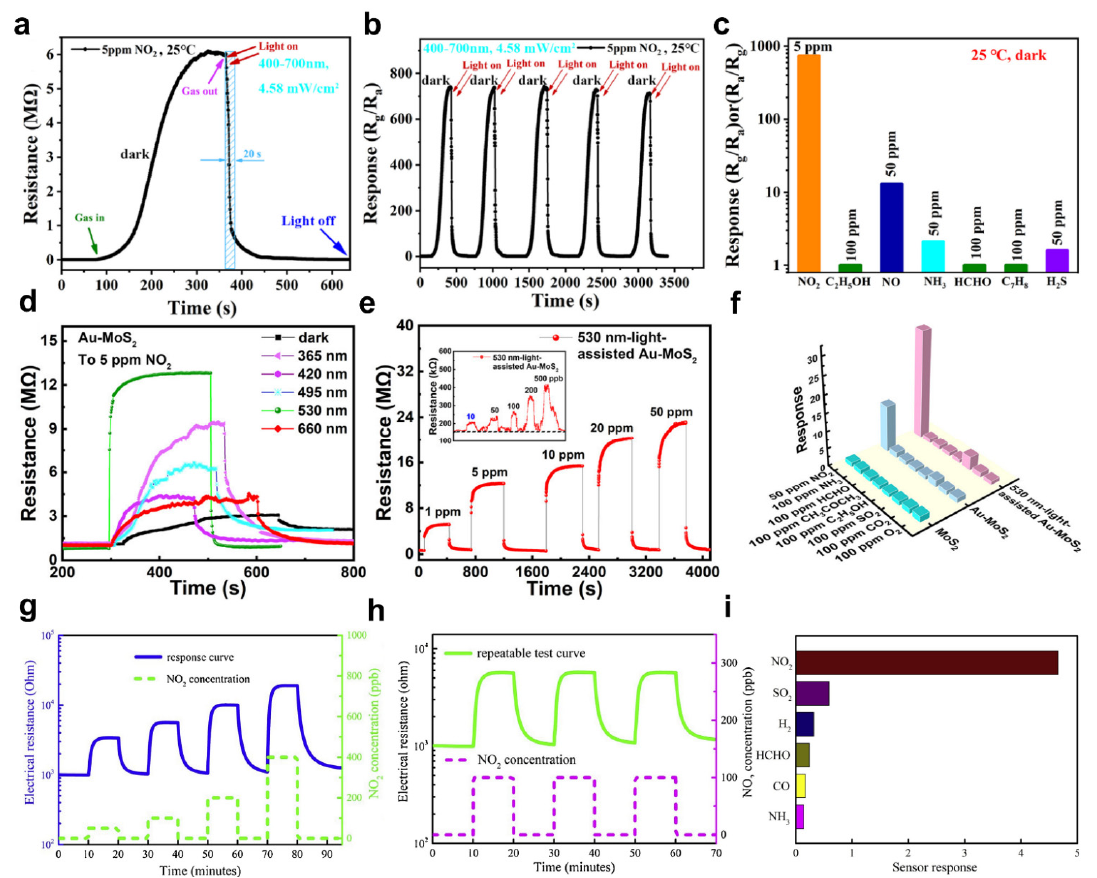
Figure 7. ( a ) Response of the In 2 O 3 NWs gas sensor with visible light irradiation; ( b ) stability characteristics of the In 2 O 3 NWs gas sensor; ( c ) selectivity characteristics of the In 2 O 3 NWs gas sensor (adapted from [99] with permission from the Elsevier B.V.); ( d ) response of the Au − MoS 2 gas sensor with UV and visible light; ( e ) response of the Au − MoS 2 gas sensor with various NO 2 gas concentration; ( f ) selectivity characteristics of the Au − MoS 2 gas sensor (adapted from [100] with permission from the American Chemical Society); ( g ) electrical resistance response of the rGO@ZnO sensor with white light illumination; ( h ) repeated NO 2 gas response of the rGO@ZnO sensor; ( i ) selectivity characteristics of the rGO@ZnO sensor (adapted from [101] with permission from the Elsevier B.V.).